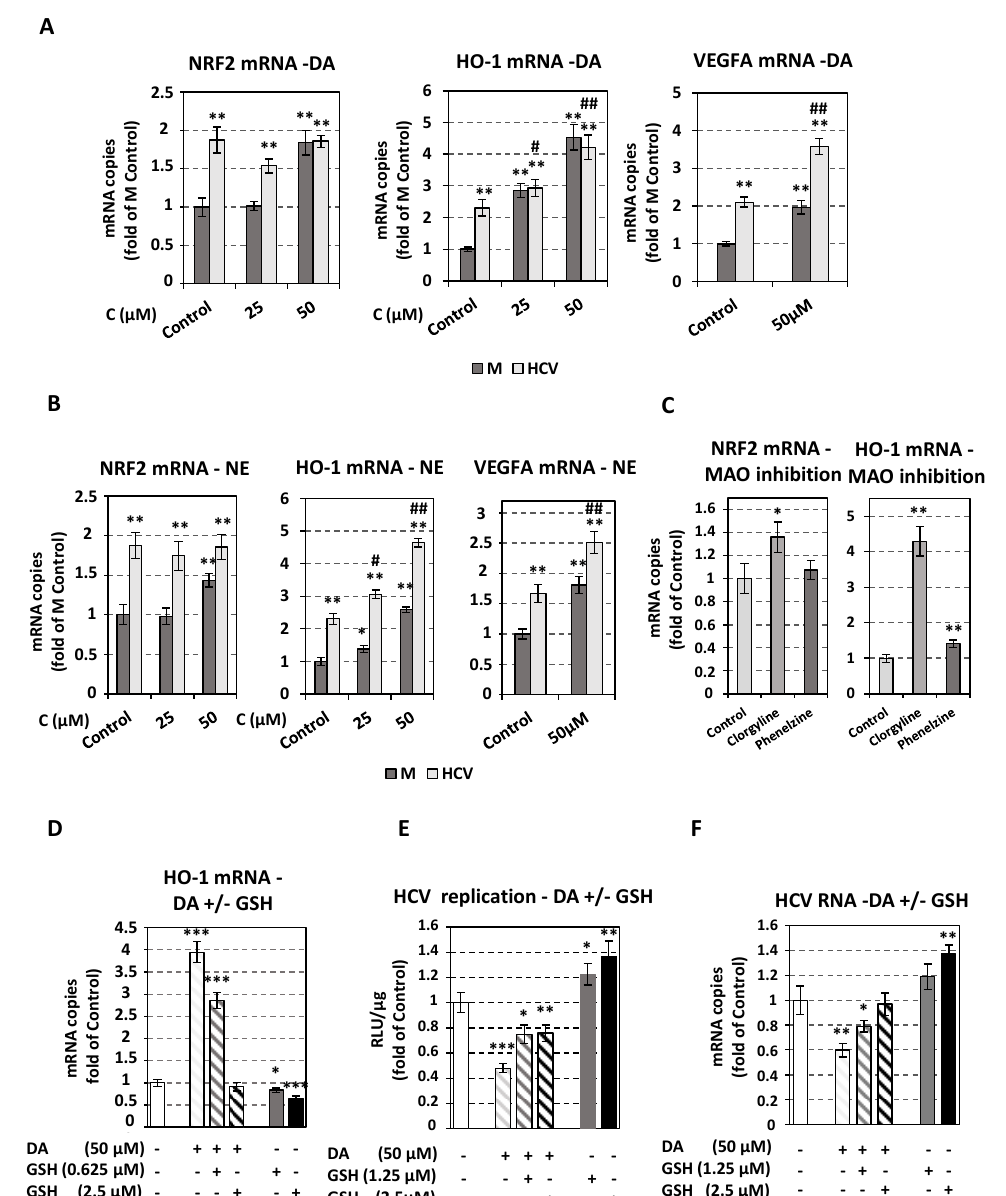
Figure 7. Effect of oxidative stress related to catecholamine biosynthesis and metabolism on HCV replication. Huh7.5 cells were inoculated with Jc1 (MOI = 1) ( A , B , D , F ) or JcR2A (MOI = 0.5) ( E ) for 4 h or mock ‐ infected (M) and subsequently treated or not (Control) for 72 h with different concentrations of catecholamines (DA, NE), MAO inhibitors (clorgyline, phenelzine), or GSH. ( A , B ) NRF2, HO ‐ 1, VEGFA mRNA levels in infected or mock ‐ infected cells, treated with DA ( A ) or NE ( B ), were quantified by RT ‐ qPCR and normalized to the mRNA levels of the housekeeping gene YWHAZ. Values from M Control cells were set to one. ( C ) NRF2 and HO ‐ 1 mRNA levels treated with clorgyline or phenelzine mock ‐ infected cells, were quantified by RT ‐ qPCR and YWHAZ mRNA was used for normalization. Values from Control cells were set to one. Bars represent mean values from at least three independent experiments in triplicate. Error bars indicate standard deviations. * p < 0.01, ** p < 0.001 vs. M (mock ‐ infected) Control, # p < 0.01, ## p < 0.001 vs. HCV ‐ infected Control. ( D – F ) Effect of DA and GSH combinatory treatment on the expression of HO ‐ 1 antioxidant gene and on HCV replication, in infected cells. ( D ) HO ‐ 1 mRNA levels were quantified by RT ‐ qPCR and YWHAZ mRNA was used for normalization. ( E ) Virus replication ‐ derived R ‐ Luc activity was determined in cell lysates and expressed as RLU/ μ g of total protein amount. ( F ) Jc1 positive ‐ strand RNA levels were quantified by RT ‐ qPCR and YWHAZ mRNA was used for normalization. In panels D–F, values from infected non ‐ treated cells were set to one. Bars represent mean values from at least three independent experiments in triplicate. Error bars indicate standard deviations. * p < 0.05, ** p < 0.01, *** p < 0.001 vs. Control.